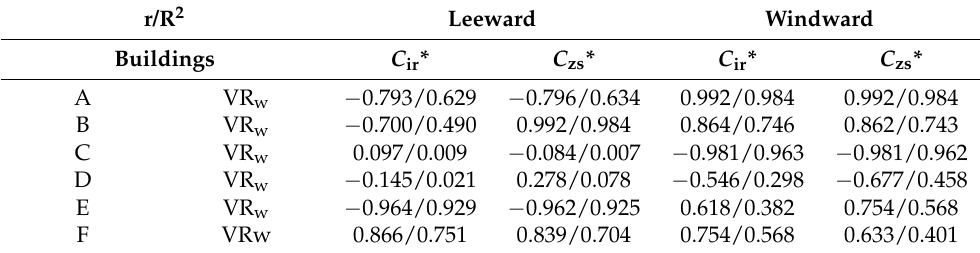
Table 2. Analysis on Spearman correlation coefficients among VR w / C zs *, C ir